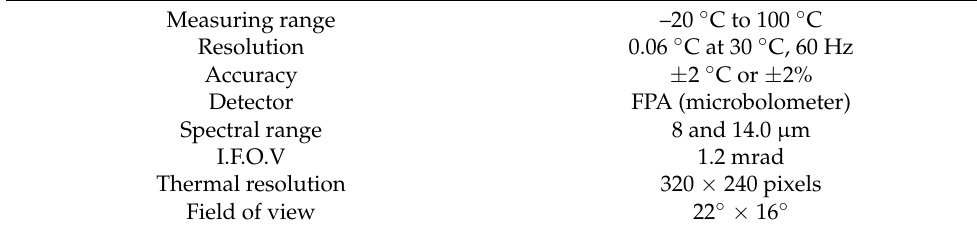
Figure 3. Equipment used in the experimental campaign: ( a ) IR camera; ( b ) emissometer. Table 3. Main specifications of the IR camera 42.